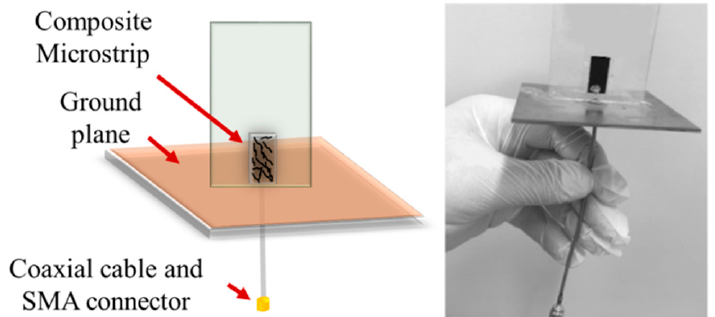
Figure 4. A schematic illustration and a photo of the microstrip resonant vapor sensor with the MWCNT/EOC microstrip.